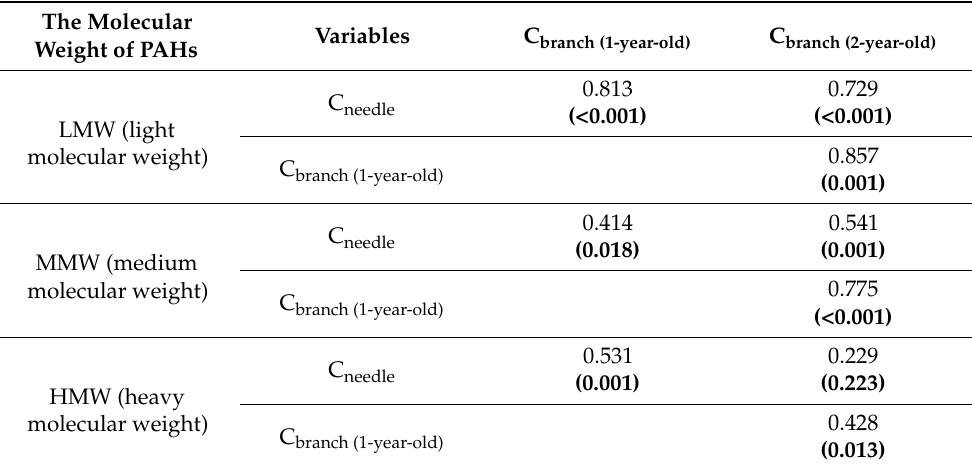
Table 4. R s values among each tree component